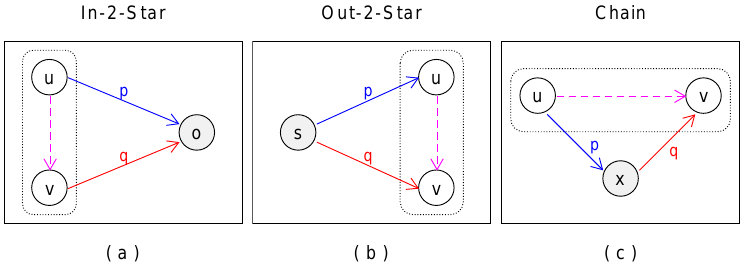
Figure 4. Extraction patterns with two predicates p , q and two triples. ( a ) In-2-Star: two connections are coming-into o from u (using p ) and v (using q ). ( b ) Out-2-Star: two connections are going-out s to u (using p ) and to v (using q ). ( c ) Chain: two successive connections between u and v via x , using p and q